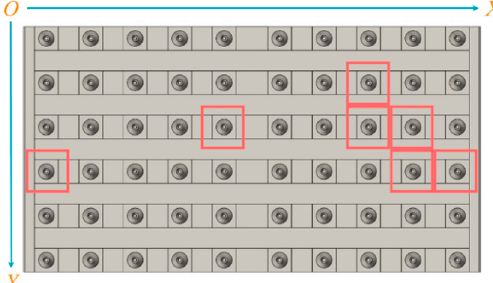
Figure 16. Positioning of the positioned seed suction nozzle.